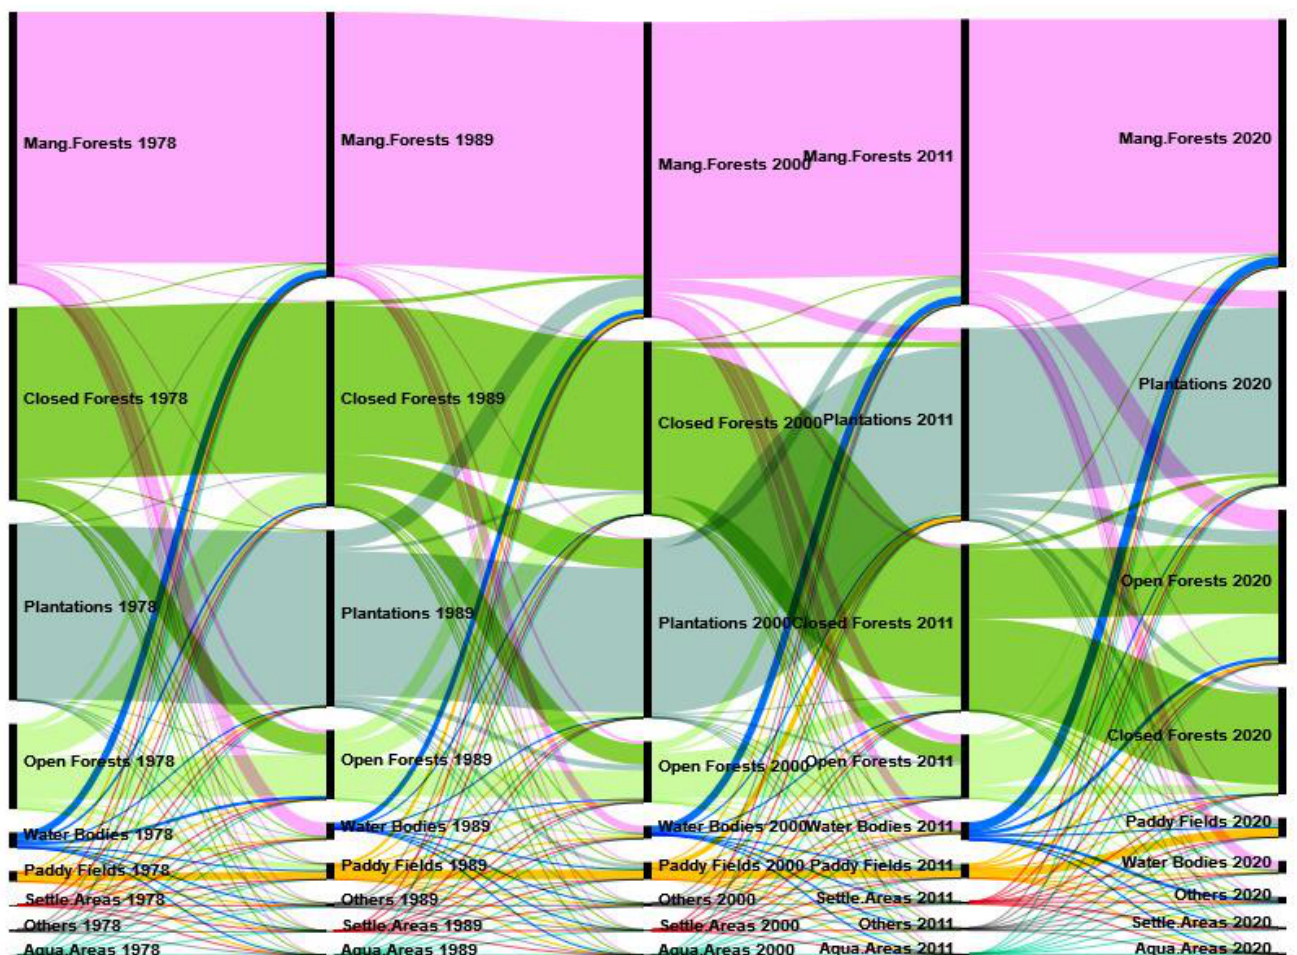
Figure 6. Transformation of LULC classes in Kyunsu township of Southern Myanmar across 40 years. The large area of stable Water Bodies in each year was excluded for the visualization of the transformation of the small LULC classes. Data of LULC transformation are provided in Tables S3– S7.